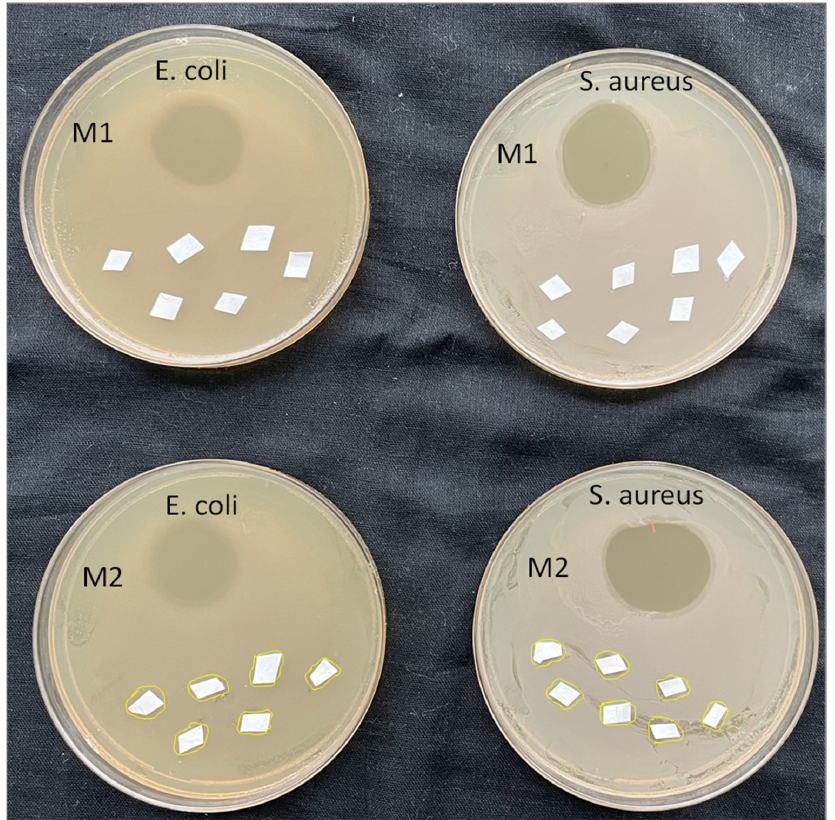
Figure 13. The antibacterial results of the M1 and M2 membrane after being subjected to 24 h with E. coli and S. aureus .